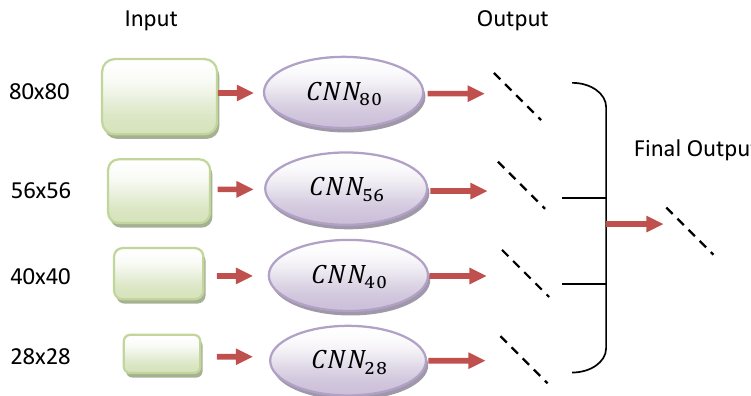
Figure 5. The global architecture of the multi-scale convolutional neural network